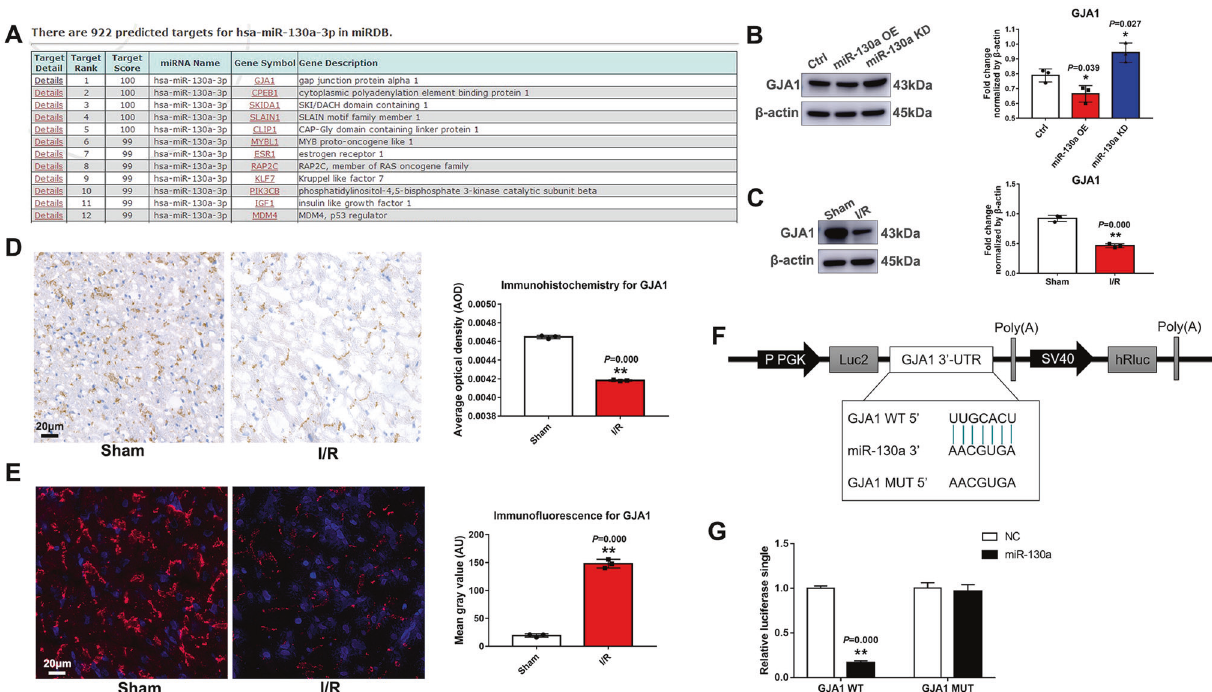
Fig. 5 GJA1 is the target of miR-130a and is downregulated in I/R rats. A Hsa-miR-130a-3p targets were predicted in the miRDB database. B The levels of GJA1 expression were assessed by western blot of Ctrl, miR-130a KD, and miR-130a OE cells. n = 3 in each group. Data were expressed as mean ± SD; Statistical signi fi cance by two-tailed Student ’ s t-test, * P < 0.05 vs . Ctrl. C The levels of GJA1 expression were assessed by western blot in rat myocardial tissues in sham and I/R groups. n = 3 in each group. Data were expressed as mean ± SD; Statistical signi fi cance by two-tailed Student ’ s t-test, ** P < 0.01 vs . the sham group. D , E GJA1 expression was measured by IHC and IFA. Bar = 20 μ m. F – G MiR-130a targets the GJA1 3 ’ UTR. F . Alignment of the GP-miRGLO-GJA1-3 ’ -UTR-WT, GP-miRGLO-GJA1-3 ’ -UTR-Mut luciferase reporter plasmids, and miR-130a sequence. G . Luciferase reporter activities of the cells transfected with the luciferase reporter plasmids containing the miR-130a binding sites of GJA1 3 ’ -UTR (GJA1 WT) or not (GJA1 MUT) in the NC and miR-130a mimic groups. Data were expressed as mean ± SD; ** P < 0.01 vs .